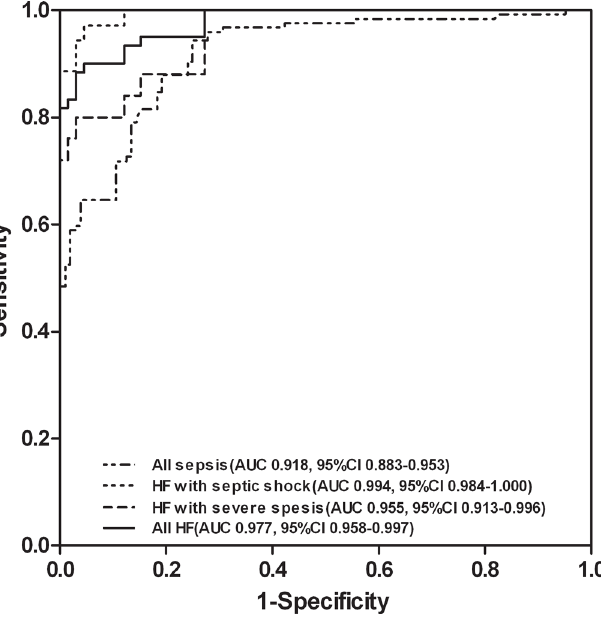
Fig 3. Comparing ROC curves for plasma NT-proBNP in all pediatric patients with sepsis, HF patients with severe sepsis, HF patients with septic shock, and all HF patients with